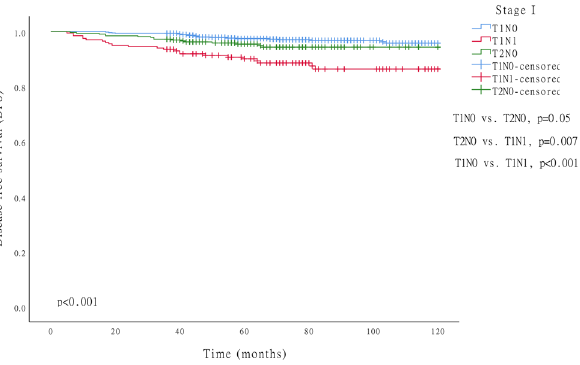
Figure 2: Comparison of survival curves in patients with stage I GC ( p < 0.001 ) .